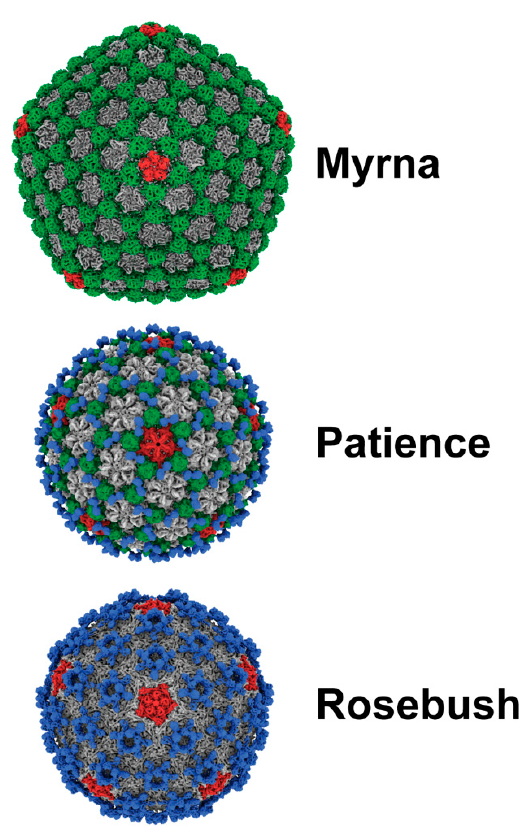
Figure 3. Capsid structure of the actinobacteriophages. Myrna (7.7 Å resolution from 2268 particles), Patience (5.9 Å resolution from 3461 particles) and Rosebush (6.7 Å from 3489 particles) cryo-EM maps. Pentamers are colored red, minor capsid proteins green and decoration proteins blue. Major capsid protein hexamers are grey in color. Cryo-EM maps in this figure and following figures were displayed using the ChimeraX software [28]. EMDB accession numbers are as follows: Rosebush: EMD-21122, Patience: EMD-21123, Myrna: EMD-21124.